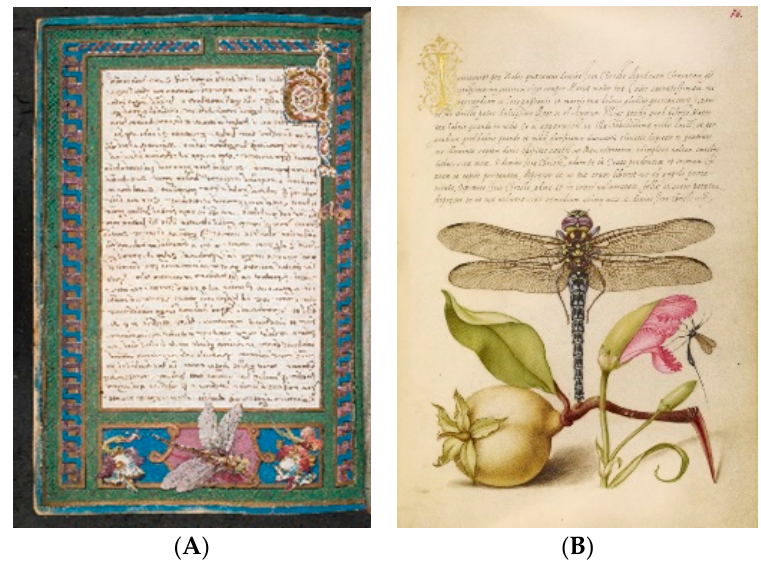
Figure 2. ( A ) Page from Caesar’s De bello Gallico with added border incorporating a dragonfly and emblems of the Visconti family [74]; ( B ) Dragonfly, Pear, Carnation, and Insect in Mira Calligraphiae Monumenta , 1561–1562, illumination added 1591–1596 by Joris Hoefnagel; J. Paul Getty Museum, Ms. 20, fol. 76 [75].